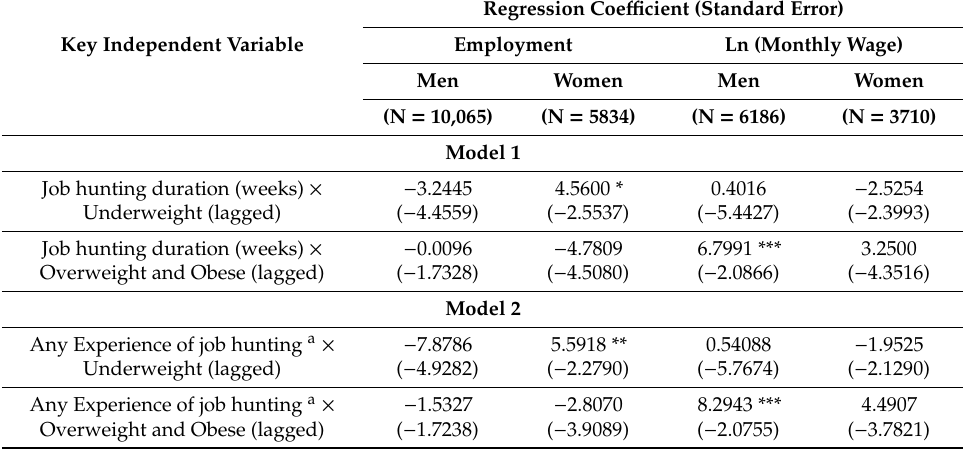
Table 4. Changes in the incremental e ff ect of the BMI group on labor market outcomes by job hunting or training e ff orts.